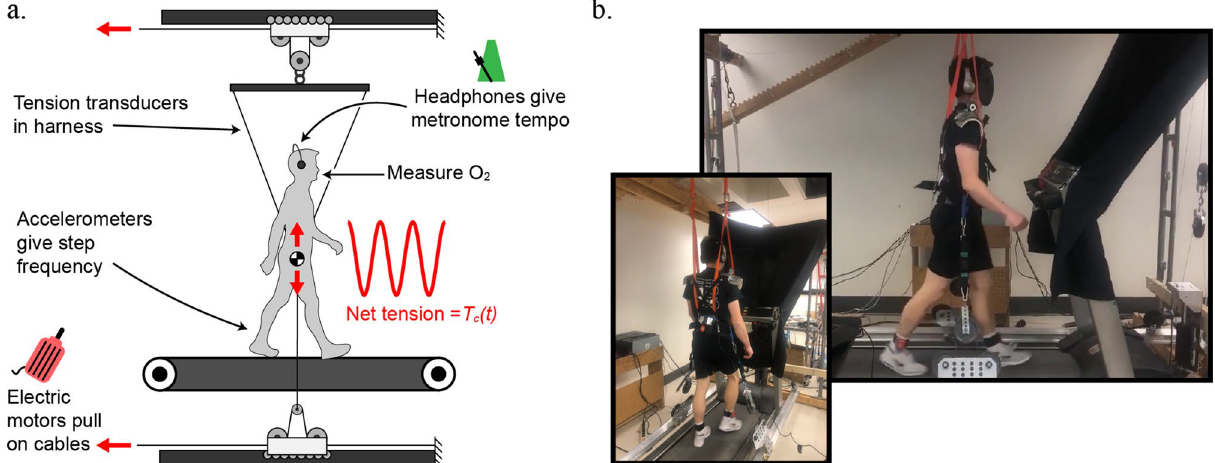
Figure 1. System schematic and images. ( a ) A schematic of the oscillator system is depicted in the sagittal plane. ( b ) Images of a subject walking in the system during a trial, from the side and from behind. Downward force came as the resultant of self-equalizing oblique cables. A curtain was used to blind the subject from any motion of the pulleys or motors, and headphones were used to play ambient noise to block out rhythmic sounds from the system. The headphones were also used to play a metronome beep during portions of the experiment. A more detailed description of the system can be found in the Supplementary